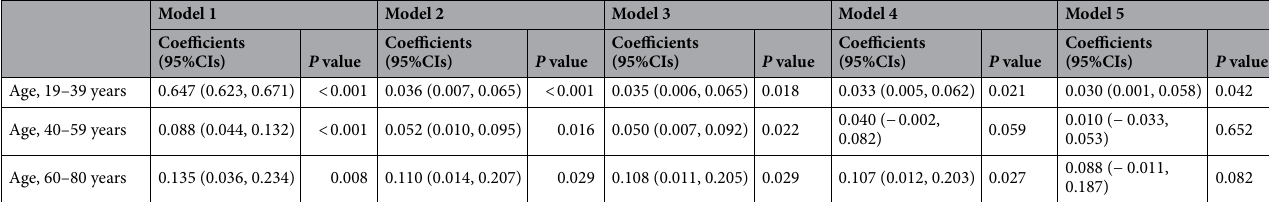
Table 6. Impact of low parental educational status on random urine Na + /Cr in the subgroups stratified by age. Model 1, unadjusted. Model 2, adjusted for age and sex. Model 3, model 2 + adjusted for co-morbidities (high body mass index, high waist circumference, diabetes, dyslipidemia, coronary artery disease, stroke, and history of smoking). Model 4, model 3 + adjusted for eGFR and proteinuria). Model 5, model 4 + adjusted for educational status of individual subjects. CI, confidence